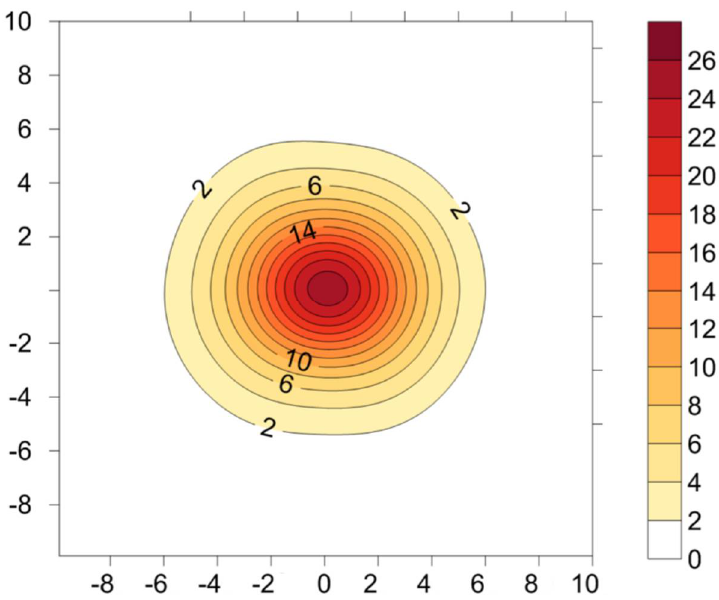
Figure 8. Radiative flux map in W/cm 2 calculated at the focal plane, related to the lamp n. 7; the